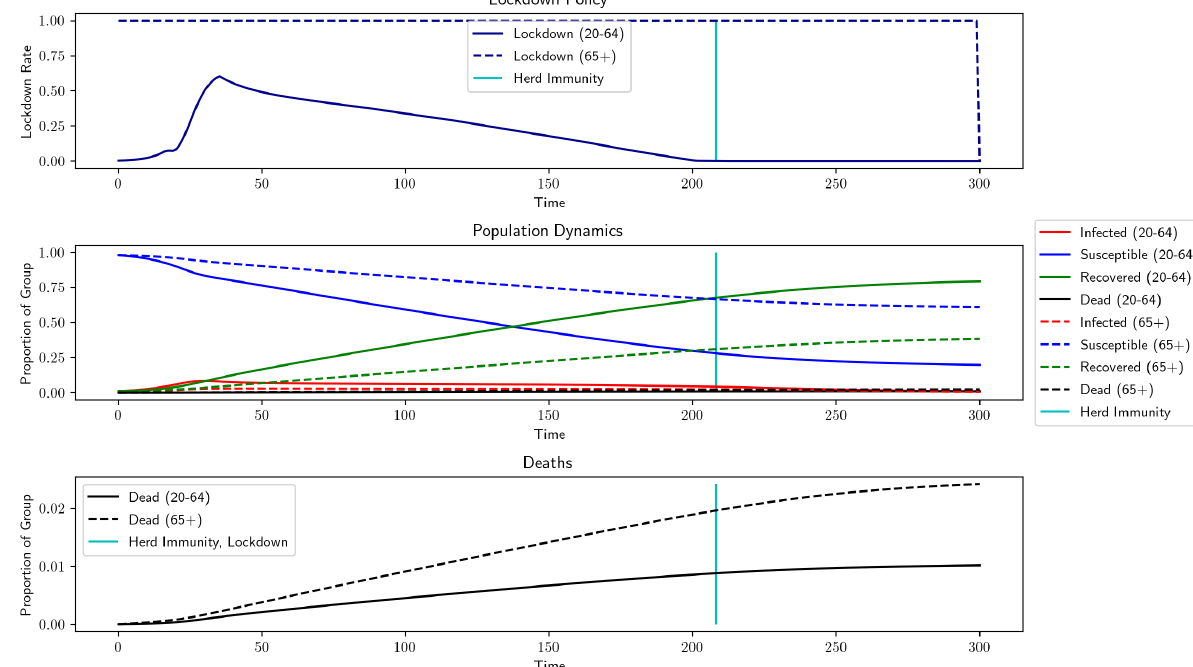
Figure 2. Our implementation of the model of [2] (two groups and no herd immunity); parameters from Table A1. Output loss: 8.9676%, total deaths: